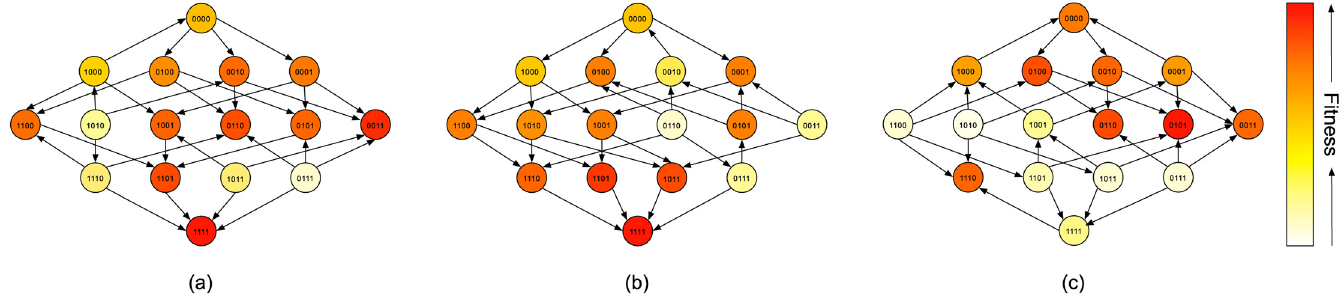
Fig 1. Example fitness landscapes. The evolutionary graphs for the fitness landscapes of E. coli with the antibiotics (a) Ampicillin, (b) Ampicillin + Sulbactam and (c) Cefprozil for 4 possible substitutions found in bla TEM-50 . Arrows represent fitness – conferring mutations which can fix under the Strong Selection Weak Mutation assumptions. The absence of an arrow in either direction corresponds to a neutral mutation which cannot fix under these assumptions. Each genotype is shaded according to its fitness normalized to a 0 – 1 scale.